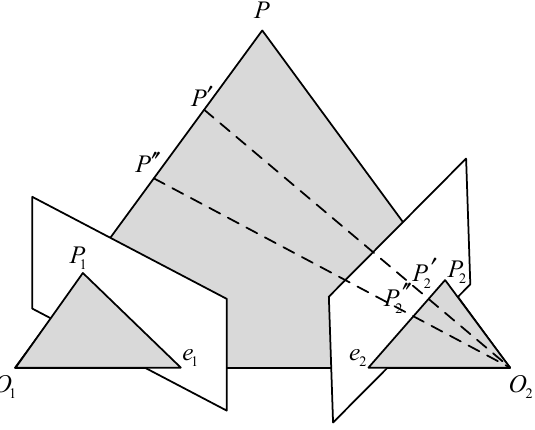
Figure 3. Polar geometry relationship.